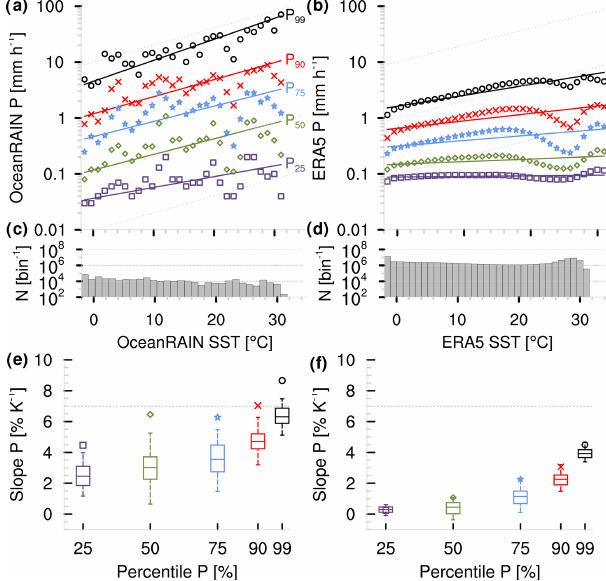
Figure 2. Five percentiles of (a) OceanRAIN (June 2010– April 2017) and (b) ERA5 (June 2010–December 2016) precipi- tation rate P (mmh − 1 ) as a function of bin-wise SST ( ◦ C) shown with linear regressions from TSE calculation. Gray lines indicate 7%K − 1 slope. (c, d) Histograms illustrate number of cases N (per bin) for all in (a) and per month in (b) . (e, f) Slopes from TSE regressions (%K − 1 ) in (a) and (b) are indicated by markers as a function of percentile. Boxes (5th–95th percentile) refer to the OLS method as a comparison, which uses the halved dataset resampled 100